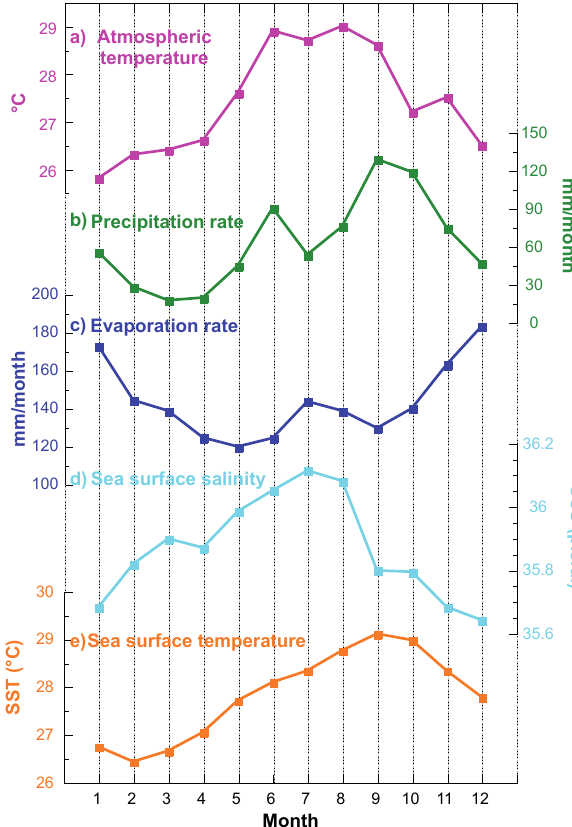
Fig. 2 Fig. 2. Monthly climate and sea-surface water parameters. (a) At- mospheric temperature from NOAA climate station 78388; (b) pre- cipitation; (c) evaporation rates from the DASILVA dataset (da Silva et al., 1994); (d) Sea-surface salinity (SSS); and (e) temperature Fig. 1 Fig. 1. The modern setting of the studied zone and the location (SST) from the LEVITUS (1994) of core MD03-2628. (a) The climatic and oceanic context of the Caribbean Sea; the purple arrows represent surface currents; the green arrows represent winds; and the blue hatched zones repre- sent the seasonal extreme positions of the Inter-Tropical Conver- gence Zone (ITCZ, e.g., Haug et al., 2003). The locations of cores ODP 999A (12 ◦ 45 0 N, 78 ◦ 44 0 W, 2827m in water depth, pink star); DSDP 502 (11 ◦ N, 80 ◦ W, 3051m in water depth, gray star); and ODP 847 (0 ◦ N, 95 ◦ W, 3373m in water depth, orange star) are also specified. (b) A zoom-in of the Walton Basin and the loca- tion of core MD03-2628 (WBk: Walton Bank). The location for the LEVITUS (1994) and the DASILVA (da Silva et al., 1994) sta- tions at 17.5 ◦ N, 77.5 ◦ W; and for the NOAA (station 78388) station (18.47 ◦ N, 77.99 ◦ W) are also specified in Fig. 1b (adapted from Reijmer and Andresen, 2007).